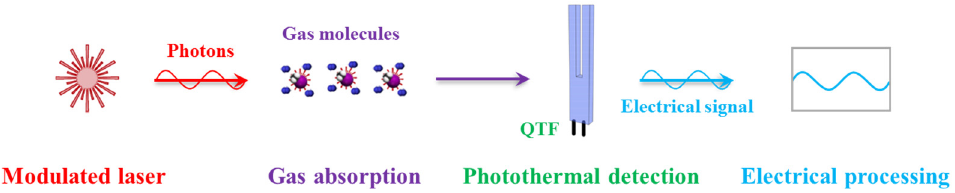
Figure 1. The schematic diagram of light-induced thermoelastic spectroscopy.